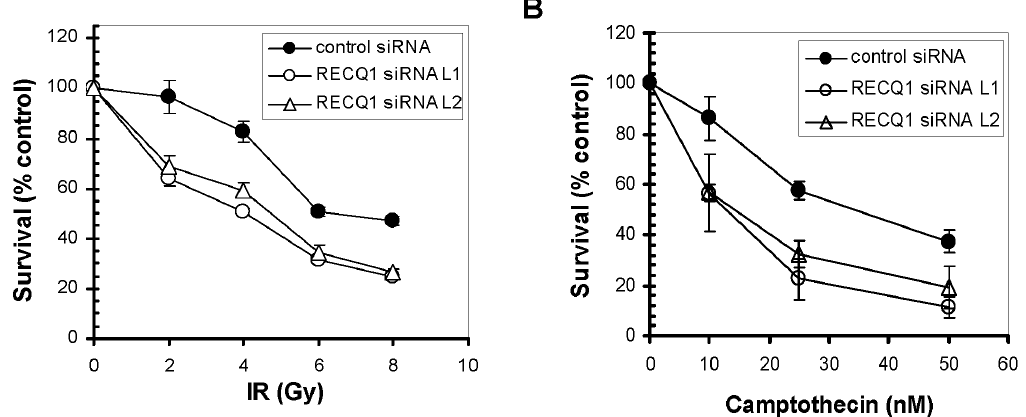
Figure 6. RECQ1 depletion sensitizes cells to DNA damage induced by ionizing radiation or camptothecin. siRNA knockdown of RECQ1 in HeLa cells leads to increased sensitivity to treatment with IR ( Panel A ) or CPT ( Panel B ). HeLa cells treated with either RECQ1 siRNA or control siRNA ( # C) were plated in quadruplicate and treated with increasing doses of IR or concentrations of CPT. Total DNA content was measured as an indication of cell growth. Two independent siRNAs ( # L1 and # L2) used to downregulate RECQ1 expression resulted in similar growth phenotype in HeLa cells. Three independent determinations of cell survival were performed and the mean 6 SD is presented.